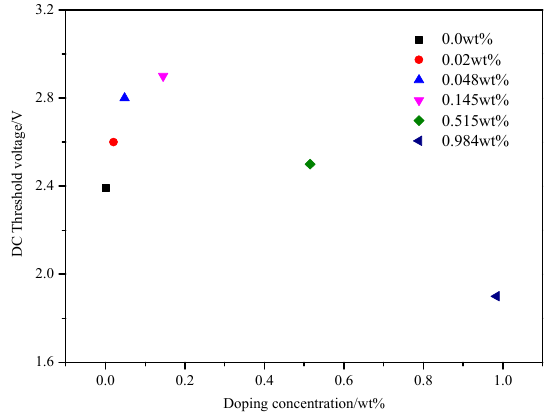
Figure 10. DC threshold voltage versus doping concentration of the LC material MAT-09-1284 doped with γ -Fe 2 O 3 nanoparticles in PAN cell.